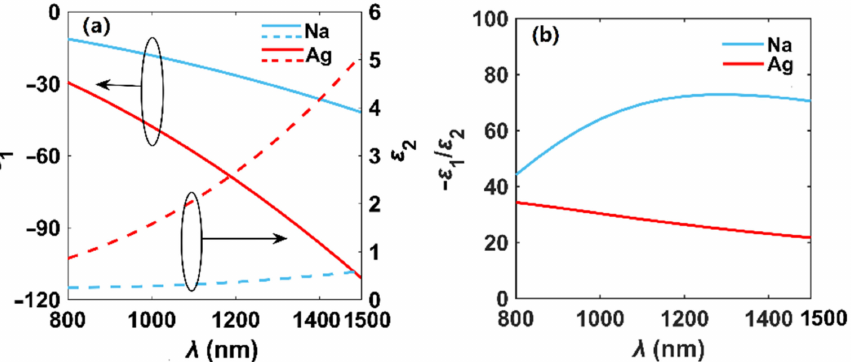
Figure 1. Permittivity ( ε = ε 1 + i ε 2 ) ( a ) and quality factor ( − ε 1 / ε 2 ) ( b ) of Na and Ag. The solid and dashed lines of ( a ) stand for the real and imaginary parts of the permittivity,